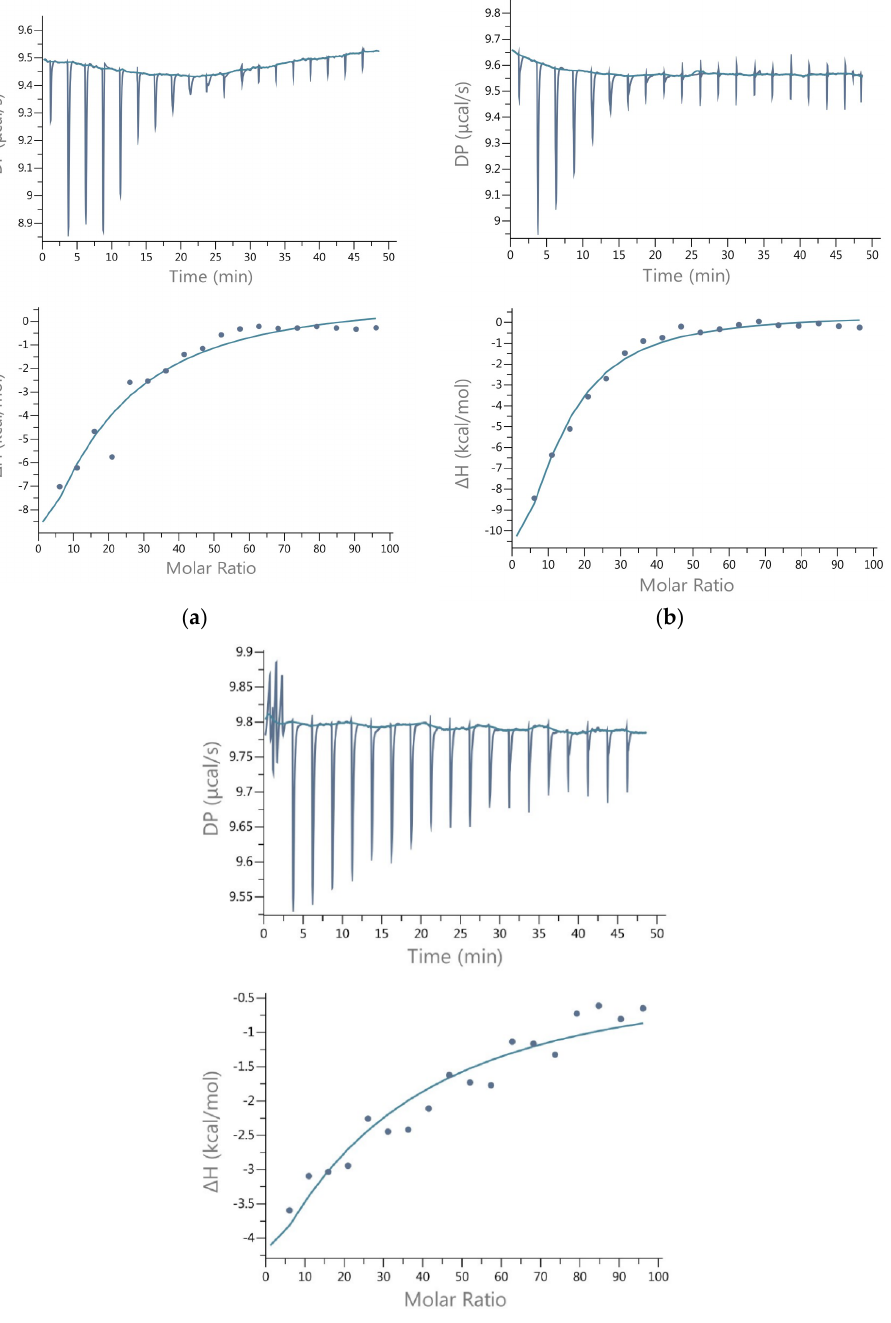
Figure 1. ITC raw data ( a ) ACh hydrolysis catalyzed by AChE; ( b ) ACh hydrolysis catalyzed by AChE in the presence of methyl syringate; ( c ) AChE titrated with methyl syringate.